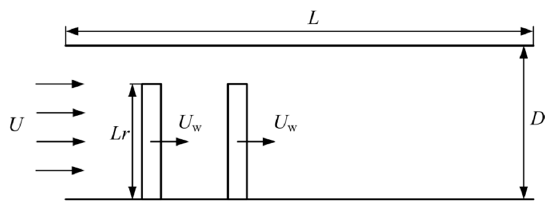
Figure 10. Physical model of double cylinders.